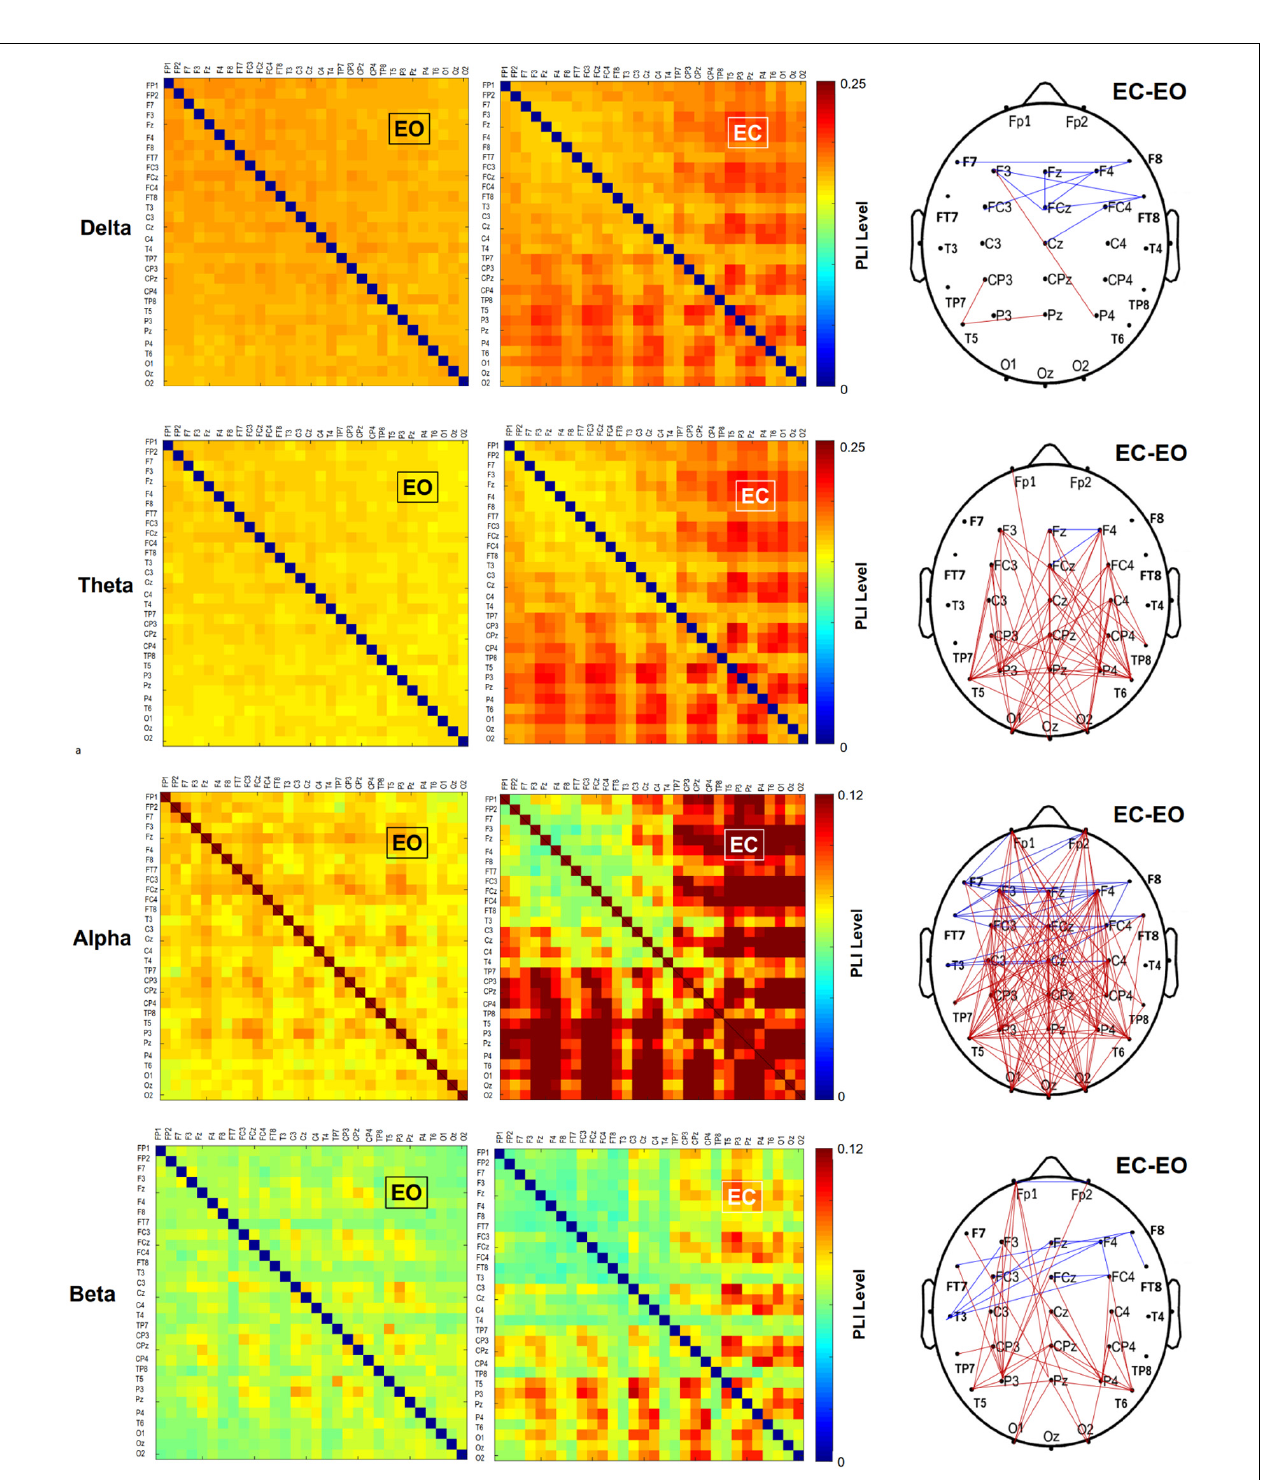
FIGURE 3 | The pooled adjacent matrix of the phase-lag index (PLI) of artifact-free EEG epochs for bilateral stance in the EO and EC conditions in different sub-bands. Paired t -tests were independently performed in a PLI matrix (30 × 30) to examine the differences in EEG connectivity of each sub-band between the EO and EC conditions. Only those t-statistics larger or smaller than an uncorrected threshold (| t 35 | > 3.340, p < 0.001) are considered as supra-threshold connections. Contrasting wiring diagrams on the scalp (the right plots) show the topological distributions of the sub-band suprathreshold connectivity that differ with and without visual input (EO vs. EC). The visual effects are band dependent, resulting in selective enhancement and depression of EEG connectivity (Red line: EC supra-threshold connectivity > EO supra-threshold connectivity, p < 0.001; blue line: EO supra-threshold connectivity > EC supra-threshold connectivity, p < 0.001).